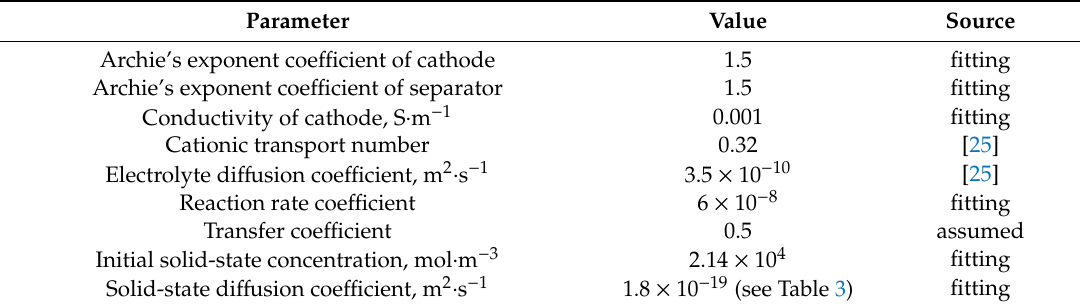
Table 2. Transport parameters of the model.